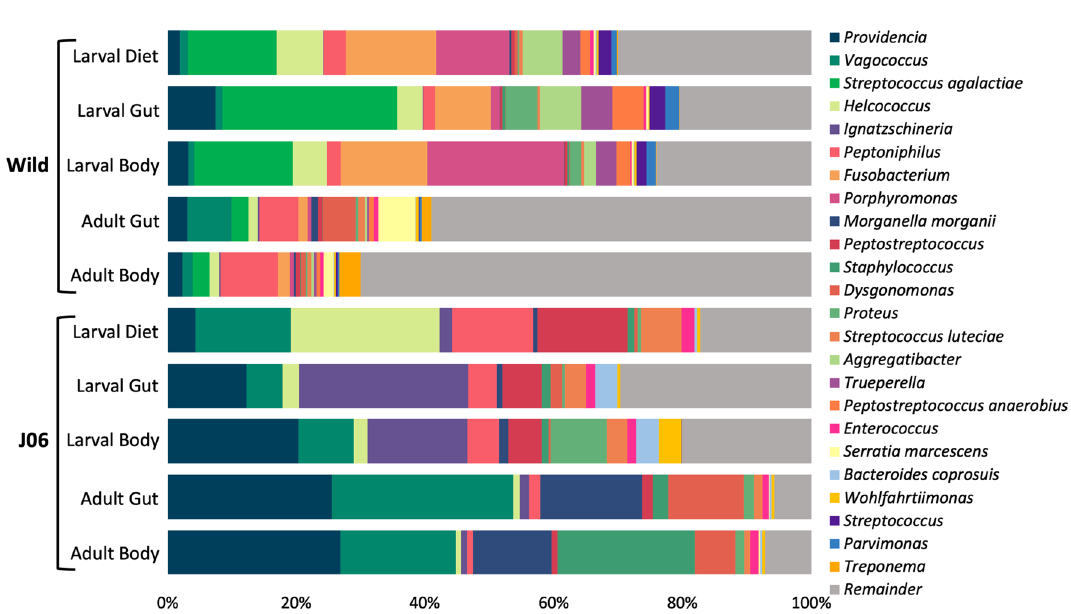
Figure 5. Stacked bar plot of the most abundant taxonomic classifications at the genus or species level. Bars are based on the average composition of samples within a sample type. Abundant classifications were selected by choosing taxa with a summed abundance across samples greater than